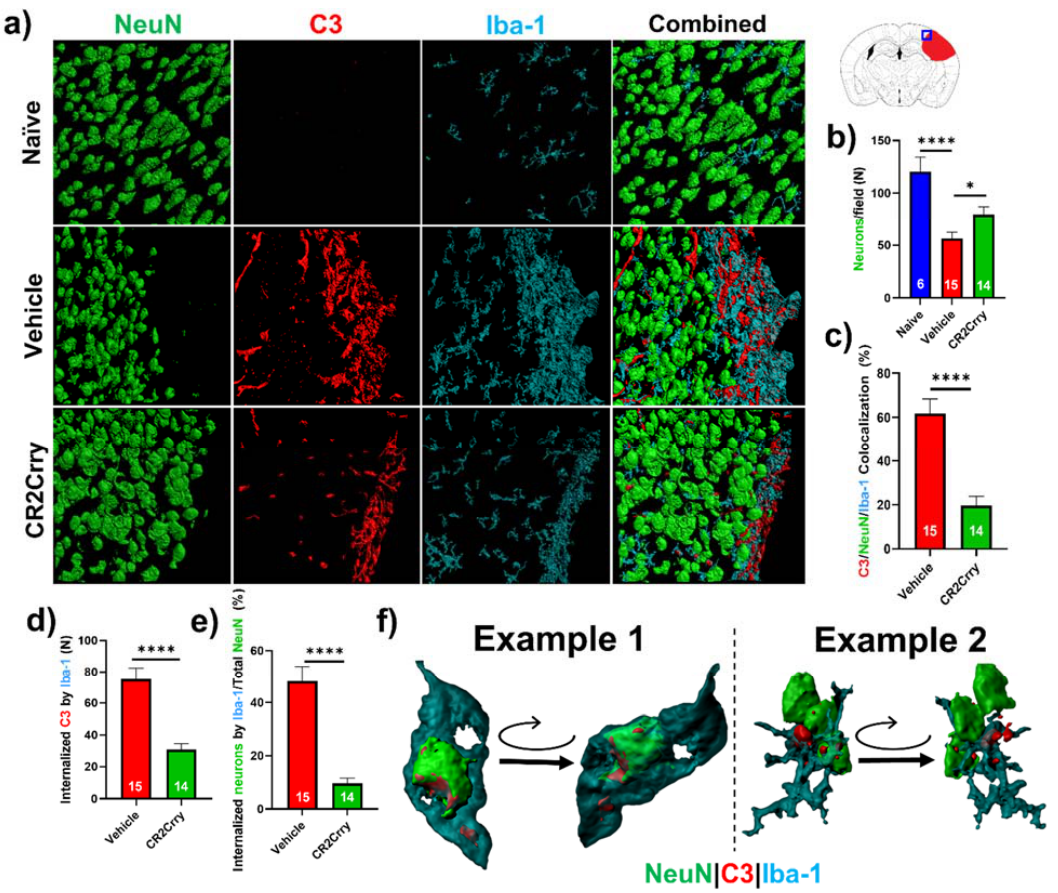
Figure 7. Complement inhibition reduces microglia/macrophage association with and internalization of C3-tagged neurons. ( a ) Representative images of perilesional area showing staining for Iba-1, C3, and NeuN, which were obtained using confocal microscopy with Z-stacking. Three-dimensional (3D) image reconstruction was performed using Imaris to obtain colocalization analysis. ( b ) Perilesional quantification of neurons in animals treated as indicated. Cortical images from naïve brains were used for comparison. * p < 0.05, **** p < 0.0001. Error bars = mean ± SEM. ( c ) IF stain for C3 deposition, Iba-1, and NeuN colocalization, performed based on surface proximity and analyzed as a percent of total neurons/field. Association of microglia/macrophages (Iba-1) with complement-tagged neurons as a percentage of total neurons present was higher in vehicle (62%) compared to CR2Crry-treated animals (20%). **** p < 0.0001. Error bars = mean ± SEM. n = 6 for naïve, n = 15 for vehicle, and n = 14 for CR2Crry. ( d ) Quantification of microglia/macrophages within the perilesional space with partial or complete internalization of C3 material. ( e ) Quantification of microglia/macrophages within the perilesional space with partial or complete internalization of NeuN+ material as a percent of total quantified neurons. **** p < 0.0001. Error bars = mean ± SEM. n = 15 for vehicle, and n = 14 for CR2Crry. ( f ) Example images showing microglia/macrophage association and internalization of C3-tagged neurons in vehicle animals (see also supplemental videos). No data points were excluded from the analysis.